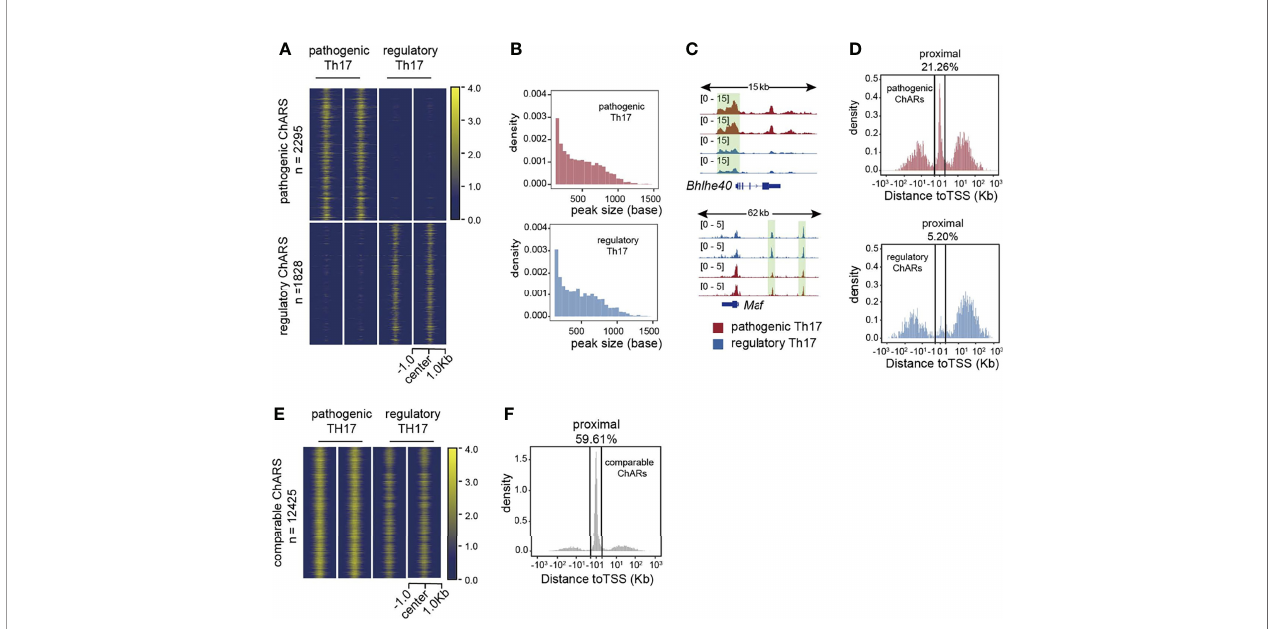
FIGURE 1 | Distributions of patho-ChARs and reg-ChARs at gene loci are different. (A) Heatmap of chromatin accessibility difference between pathogenic and regulatory Th17. (B) Peak width distributions of patho-ChARs (red) and reg-ChARs (blue). (C) ATAC-Seq tracks at Bhlhe40 and Maf gene loci in pathogenic and regulatory Th17. (D) Distance of patho-ChARs (red) and reg-ChARs (blue) to their neighboring TSSs. Percentage of ChARs found within +1 to -1 Kb of TSS were calculated. (E) Heatmap of chromatin accessibility of com-ChARs in pathogenic and regulatory Th17. (F) Distance of com-ChARs to their neighboring TSSs. Percentage of ChARs found within +1 to -1 Kb of TSS were